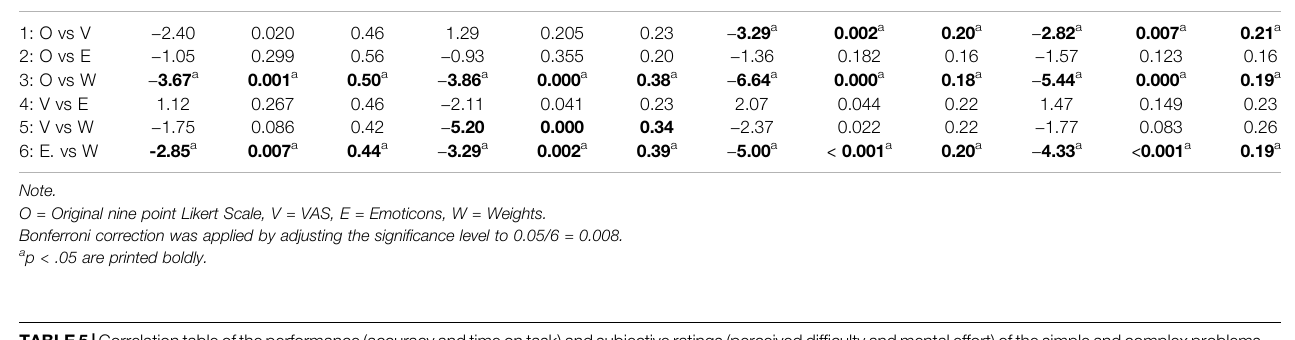
TABLE5| Correlationtableoftheperformance(accuracyandtimeontask)andsubjectiveratings(perceiveddif fi cultyandmentaleffort)ofthesimpleandcomplexproblems. N = 46